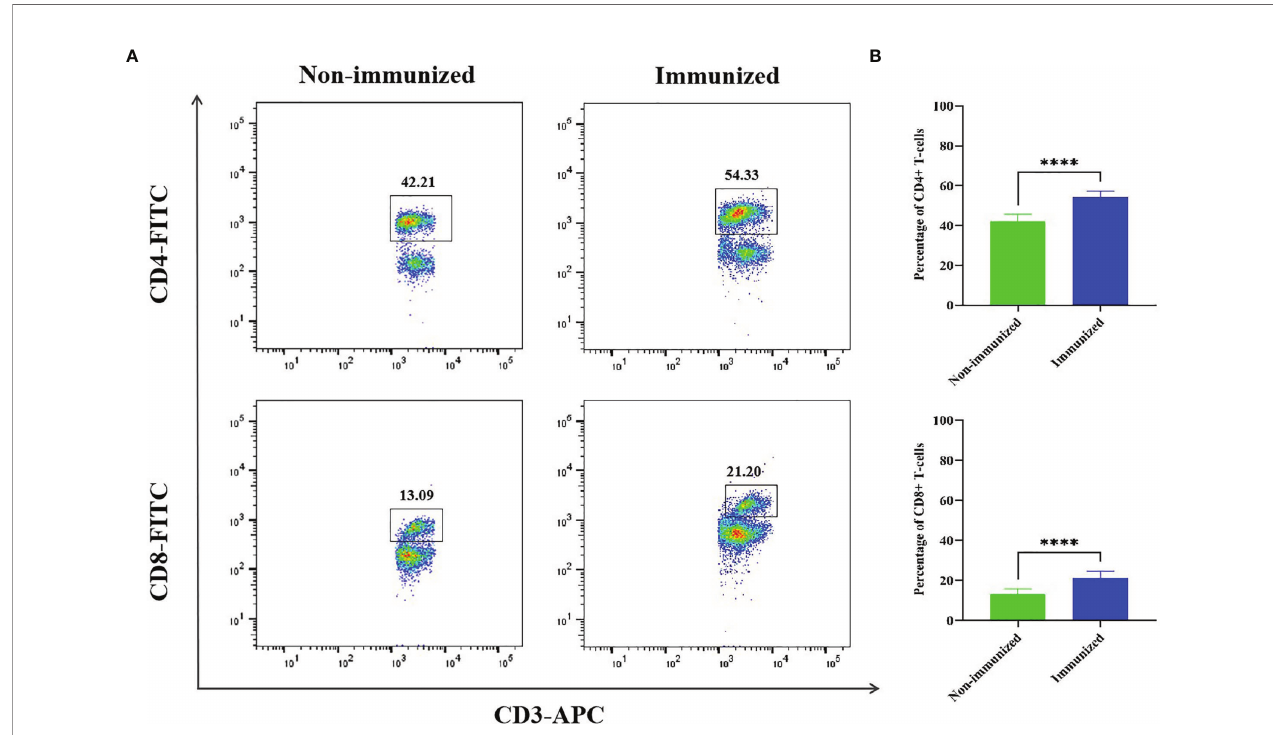
FIGURE 10 | The speci fi c cellular immunity tested by FCM. (A) Representative fl ow cytometric dot-plots of CD3 + -CD4 + and CD3 + -CD8 + T-cells in the mice splenocytes of Immunized and Non-immunized groups were shown. (B) The percentage difference of CD3 + -CD4 + and CD3 + -CD8 + T-cells between Immunized and Non-immunized groups was signi fi cant. (**** P < 0.0001).